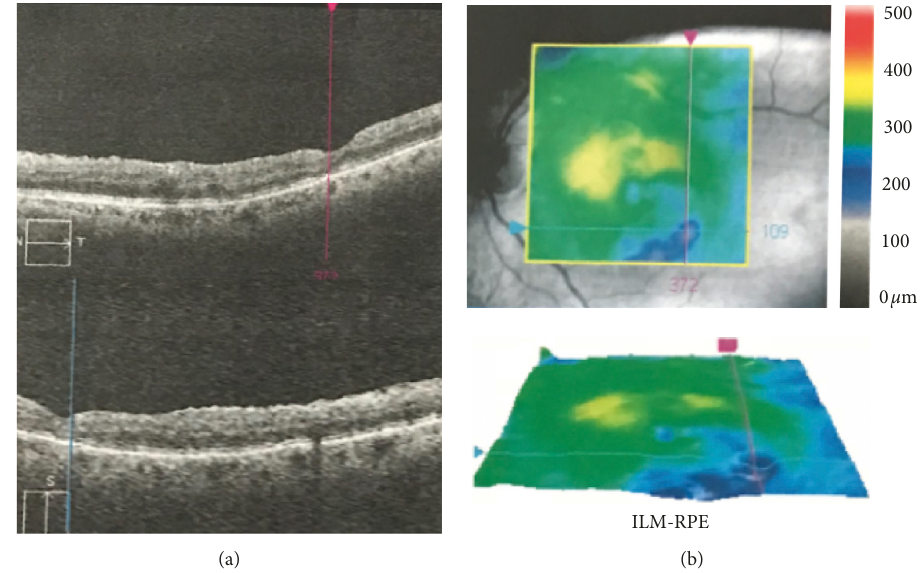
Figure 2: Optical coherence tomography (OCT) of dissociated optic nerve fiber layer (DONFL). B-scan OCT (a) illustrates the presence of a localized defect in the retinal nerve fiber layer and the underlying ganglion cell and inner plexiform layers in a patient who underwent macular hole repair surgery with internal limiting membrane peeling. A strong association with ILM peeling has been proved by different reports. (b) The color-coded altitude map shows a relative thinning of the retinal